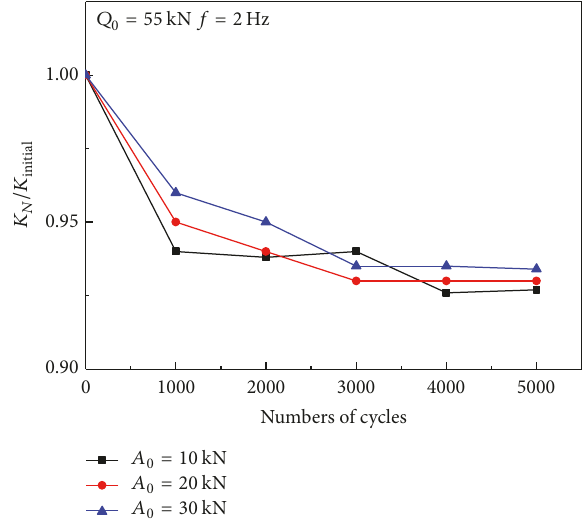
Figure 13: Variations of the secant stiffness at X-section pile head with variable loading